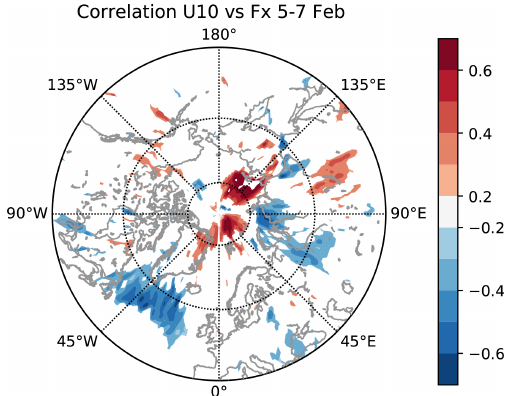
Figure 13. Correlation coefficient between zonal WAF at 500hPa averaged 5–7 February and U10 reanalysis on 12 February across individual ensemble members. All shaded coefficients are signifi- cant at p = 0 . 05.